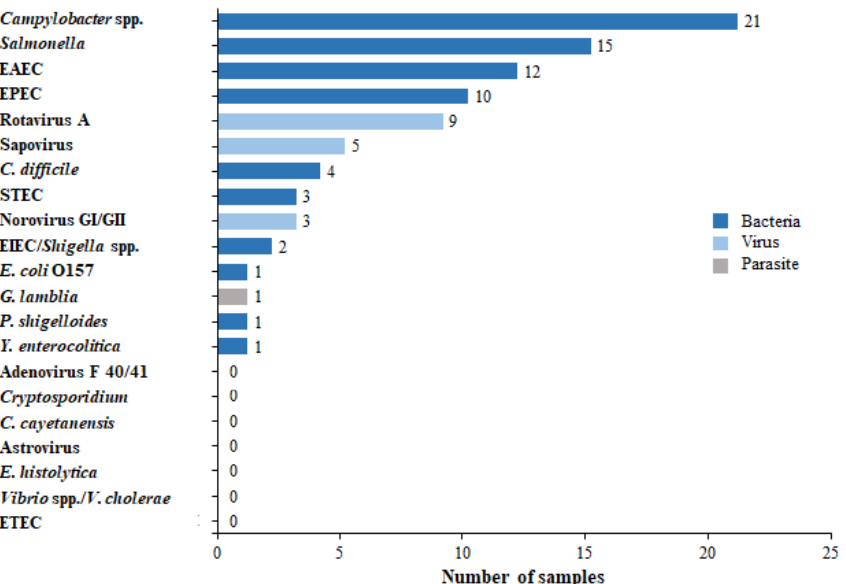
Figure 1. Distribution of causative pathogens in the study group by GIP. Sixty-one stool samples were found to be positive by the GIP for one or more pathogens. The distribution of the different detected pathogens is presented.